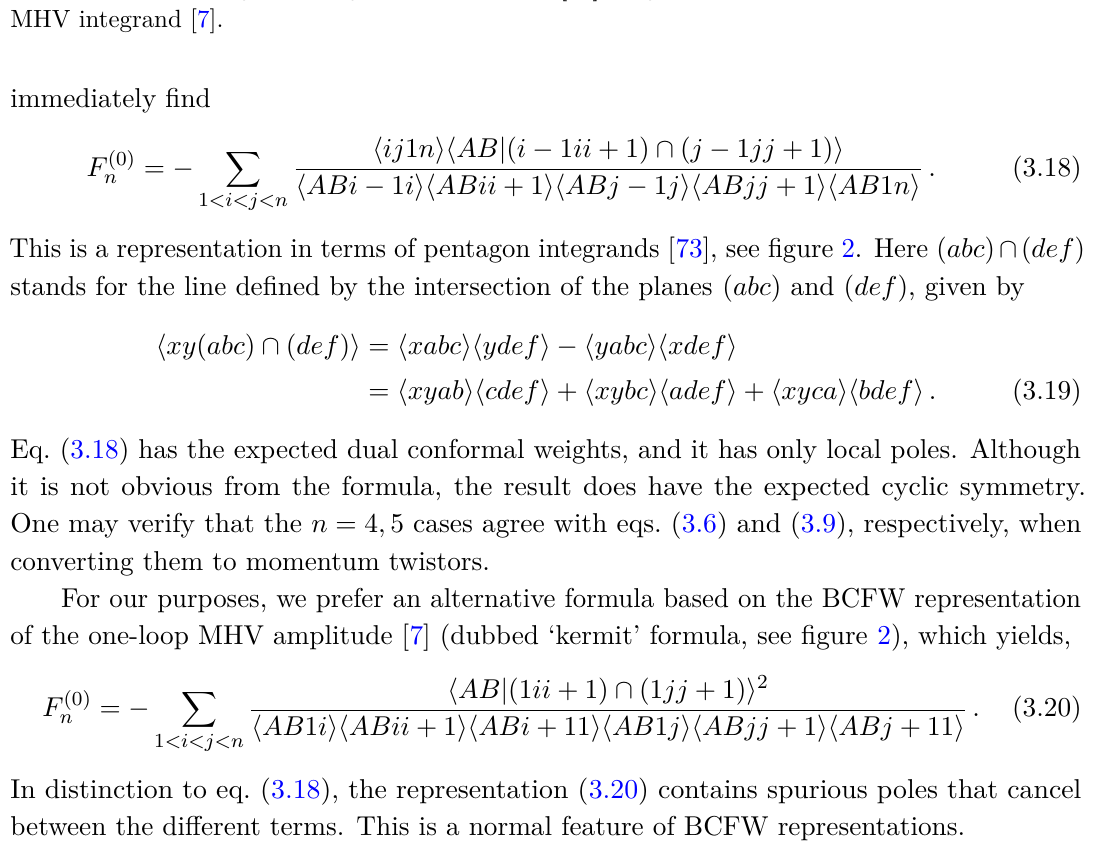
Figure 2 . Left: ‘magic’ pentagon representation [73]. Right: ‘kermit’ representation of one-loop MHV integrand